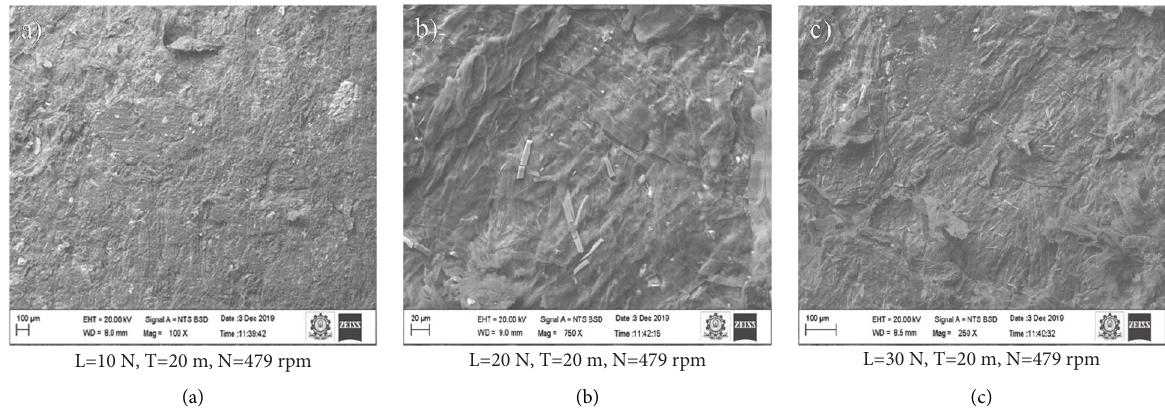
Figure 9: Electron image of water hyacinth composite material worn surface observed on the samples tested at different process conditions. (a) L � 10N, T � 20m, and N � 479 rpm. (b) L � 20N, T � 20m, and N � 479rpm. (c) L � 30N, T � 20m, and N �